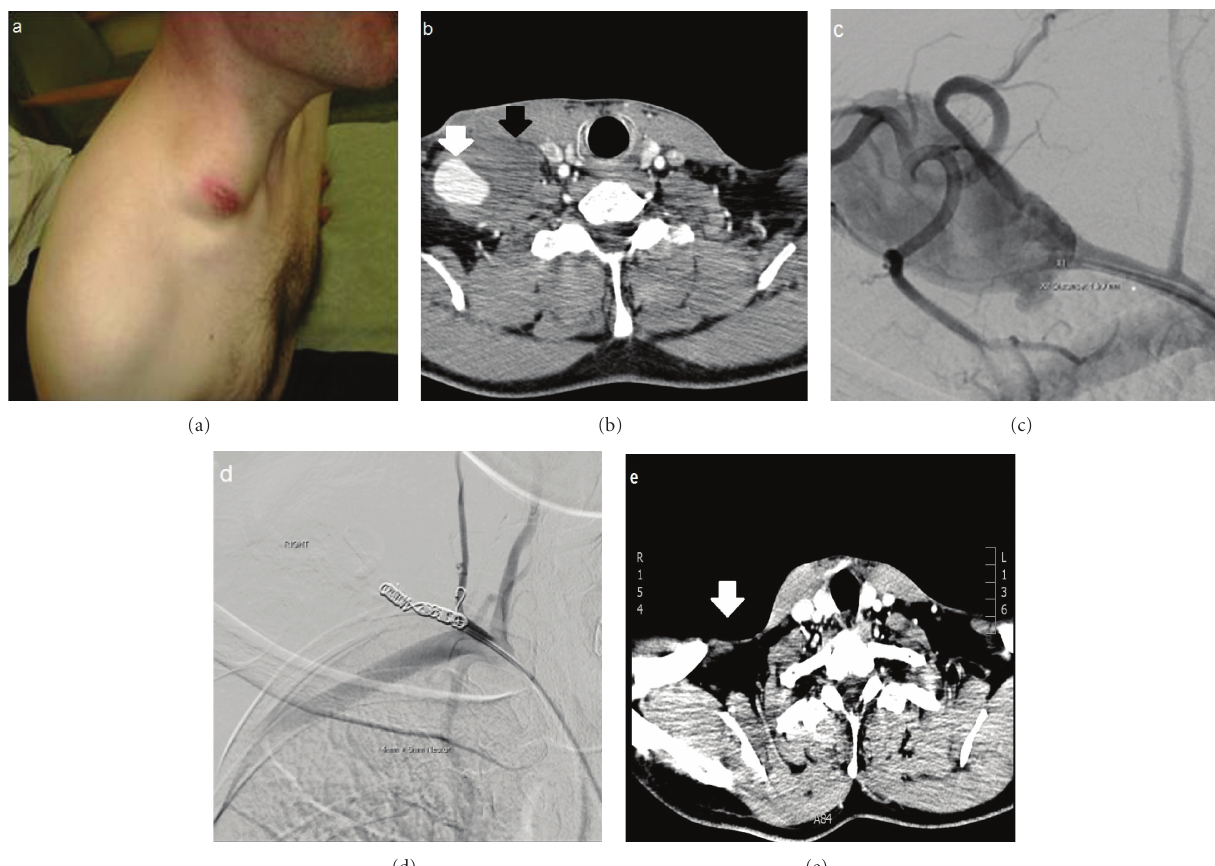
Figure 1: Right supraclavicular mass. (a) Supraclavicular mass at presentation. (b) Supraclavicular mass visualised on CT (black arrow-head) and vascular blush indicating pseudoaneurysm (white arrow-head). (c) Angiogram demonstrating pseudoaneurysm arising from branch of right dorsal scapular artery. (d) Angiogram after embolisation demonstrating occlusion of feeding vessel. (e) CT neck after 6 months of antituberculous therapy demonstrating resolution of supraclavicular mass (white